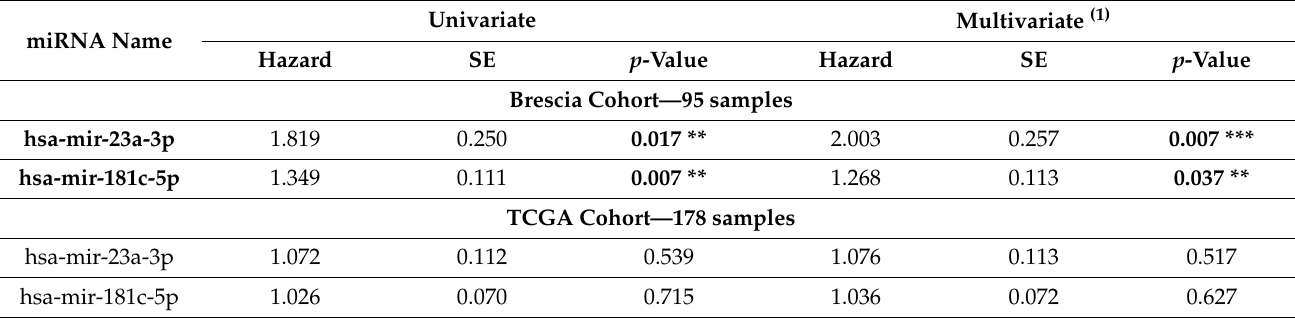
Table 3. Progression-free survival analysis. Univariate and multivariate Progression-free survival (PFS) analysis (Coxph) for miR-23a-3p and miR-181c-5p expression in both